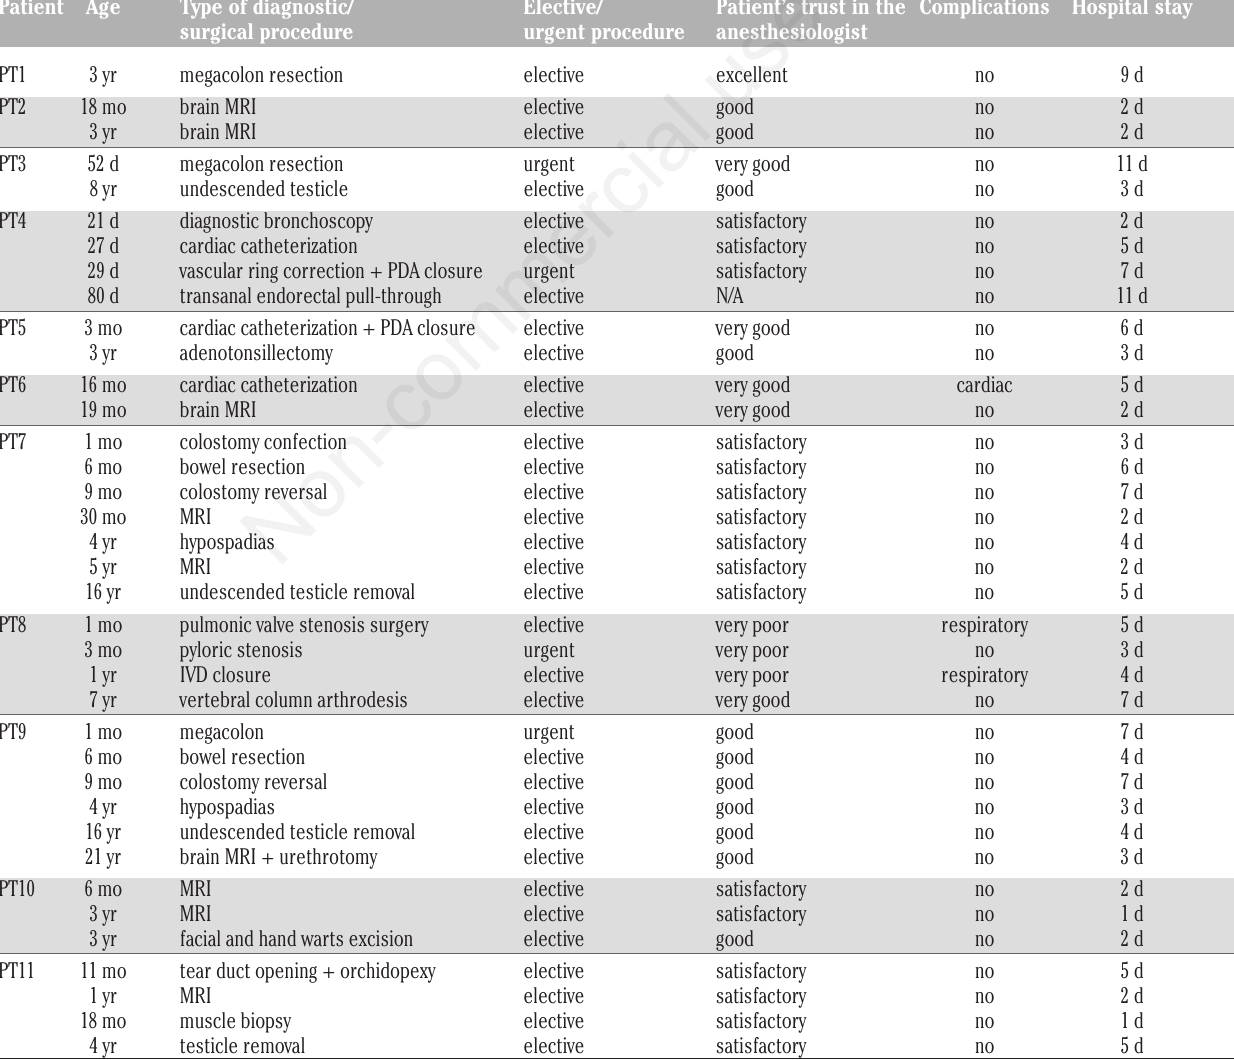
Table 1. Age of surgery and diagnostic procedures in 11 Italian patients with MWs. Patient